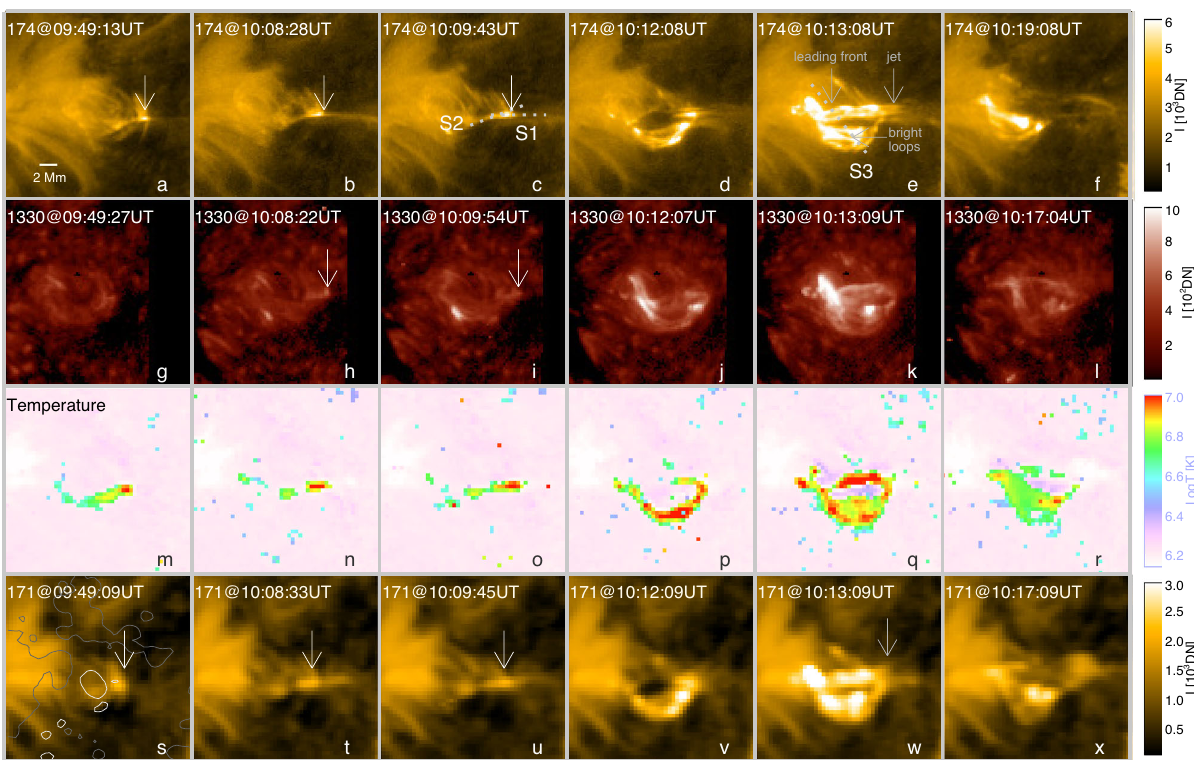
Fig.2|Signaturesandthermalstructuringofnull-pointreconnection.a – f Time sequenceofEUI/HRI EUV 174 Å imagesindicatingpersistentreconnectionatthenull- point ( a – c ) and the eruption of a spiral jet ( d – f ). The two slits (S1 and S2) with a widthofonepixelareusedformakingthedistance-timeplotsasshowninFig.4a,b; theS3slitisusedtocreateFig.4e.AlltimeshavebeencorrectedtothatattheEarth. g – r Same as a – f but for the IRIS 1330 Å slit-jaw images ( g – l ) and DEM-weighted average temperature maps ( m – r ). s – x The AIA 171 Å images of persistent